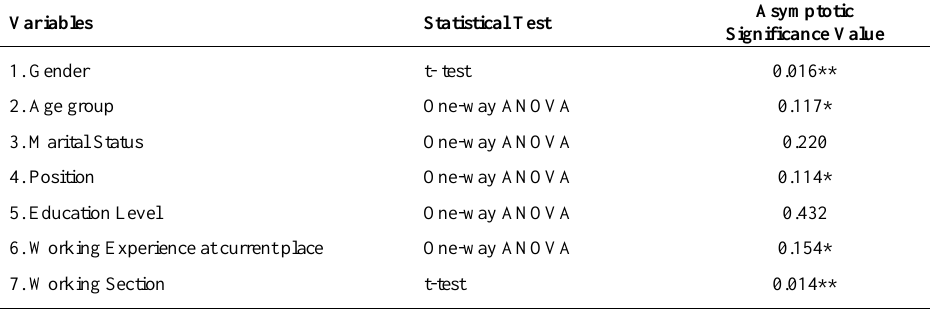
Table 3. Association between Overall Work Commitment and Socio Demographic